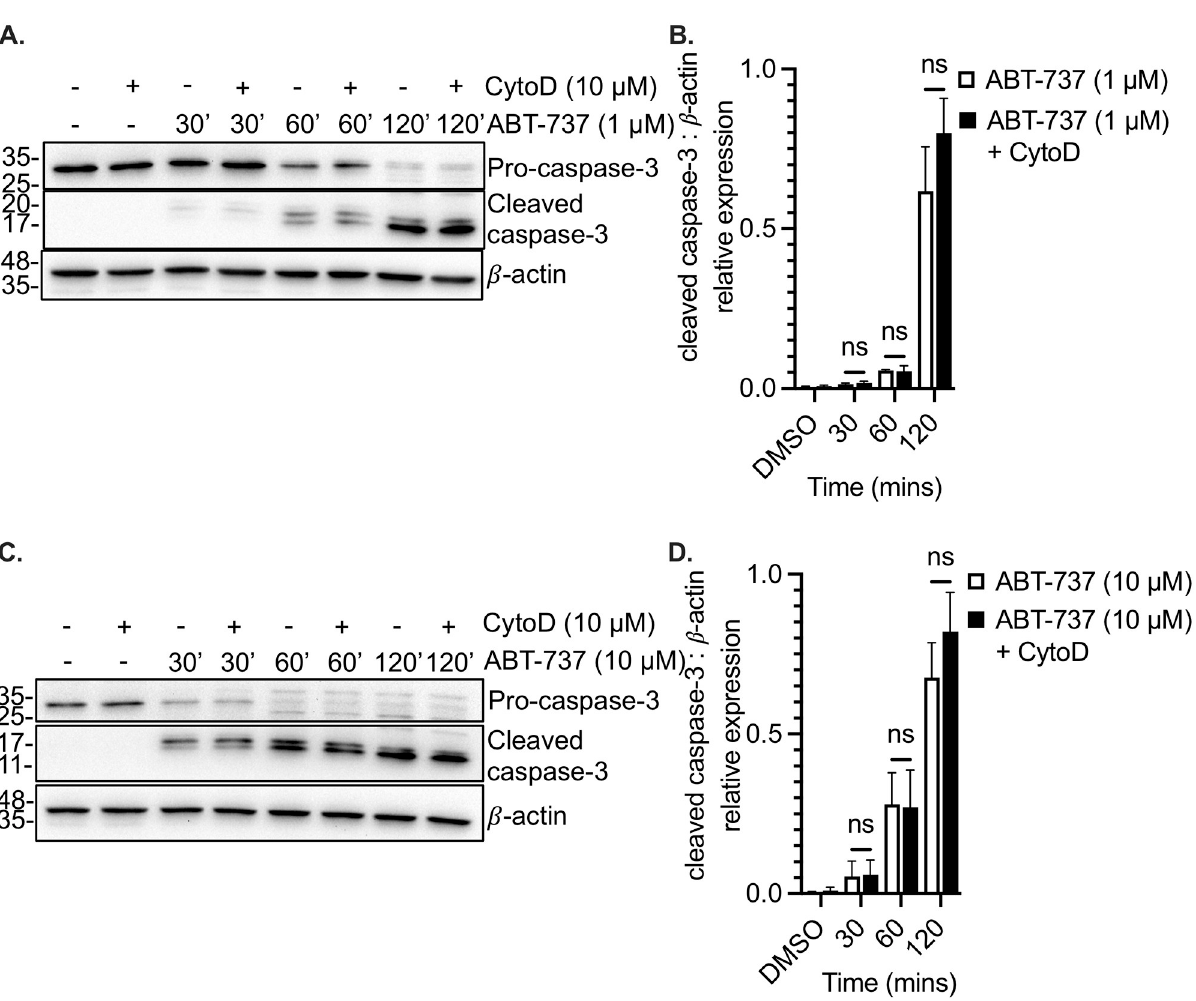
Fig 3. ABT-737-induced caspase-3 cleavage in human platelets is not affected by actin depolymerization. A . Washed human platelets were incubated in the absence (-) or presence (+) of the actin depolymerizing drug cytochalasin D, and in the absence or presence of 1 μ M ABT-737, for the indicated times. Equal amounts of platelet lysate were resolved by SDS-PAGE; immunoblots were probed for pro-caspase-3 and cleaved caspase-3. Beta- actin ( β -actin) is shown as a loading control. B . Bar graph depicts caspase-3 cleavage (normalized to beta-actin levels) induced by 1 μ M ABT-737 in the absence (ABT-737, white bars) or presence (ABT-737+CytoD) of cytochalasin D. Data are mean ± SEM, analyzed by 2-way ANOVA and Bonferroni post-hoc multiple comparison tests, and represent a minimum of 3 independent experiments using blood from different donors. C . Immunoblots represent pro-caspase-3 and cleaved caspase-3 levels in platelets treated with 10 μ M ABT-737, in the presence or absence of cytochalasin D. Beta-actin ( β -actin) is shown as a loading control. D . Bar graph depicts caspase-3 cleavage (normalized to beta-actin levels) induced by 10 μ M ABT-737 in the absence (ABT-737, white bars) or presence (ABT-737+CytoD) of cytochalasin D. Data are mean ± SEM, analyzed by 2-way ANOVA and Bonferroni post-hoc multiple comparison tests, and represent a minimum of 3 independent experiments using blood from different donors.